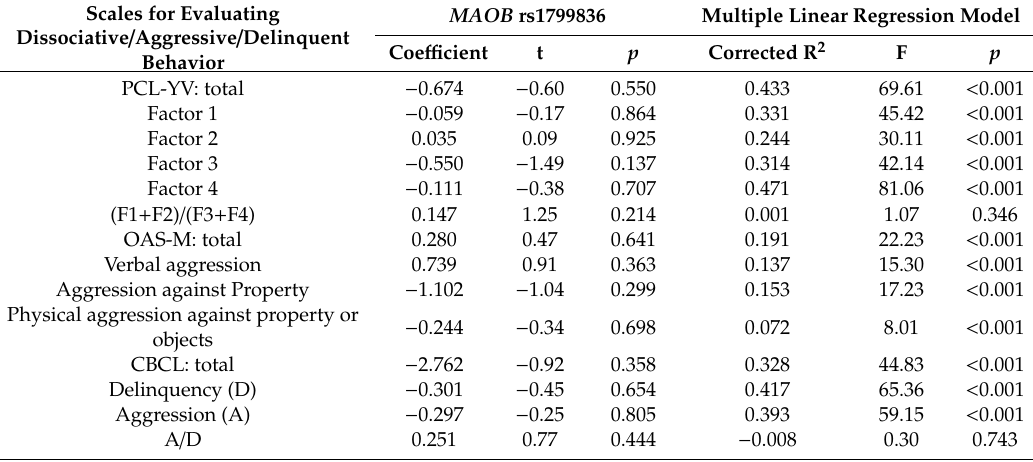
Table 4. Multiple linear regression with MAOB rs1799836 and number of scores of aggressive / dissociative / delinquent behaviors evaluated using Hare Psychopathy Checklist: Youth Version (PCL-YV), Overt Aggression Scale-Modified (OAS-M), and Child Behavior Checklist (CBCL) in